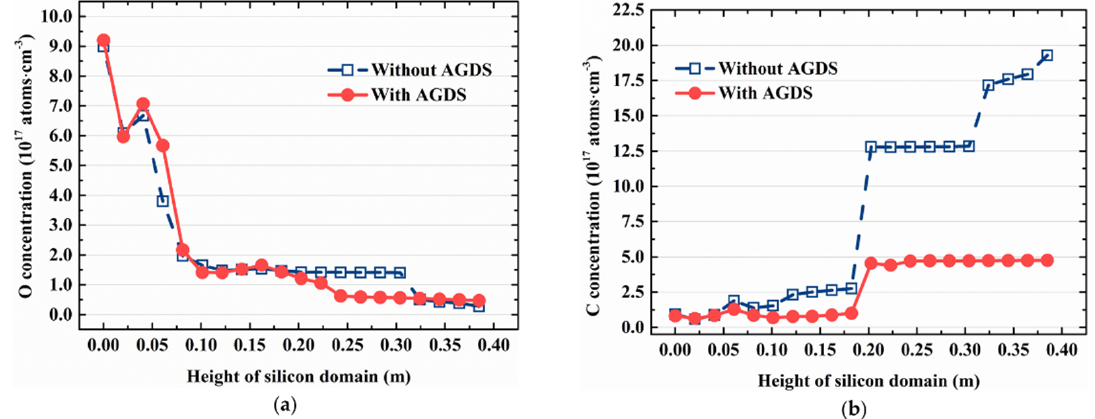
Figure 10. O ( a ) and C ( b ) concentration along the center axis of the silicon region.